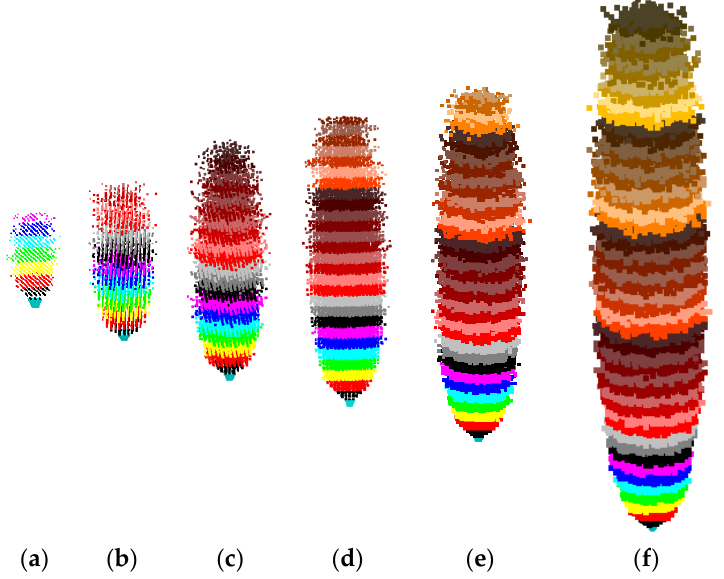
Figure 9. Shape development of IEZ. ( a ) H = 20 m; ( b ) H = 40 m; ( c ) H = 60 m; ( d ) H = 80 m; ( e ) H = 100 m; ( f ) H = 150 m.